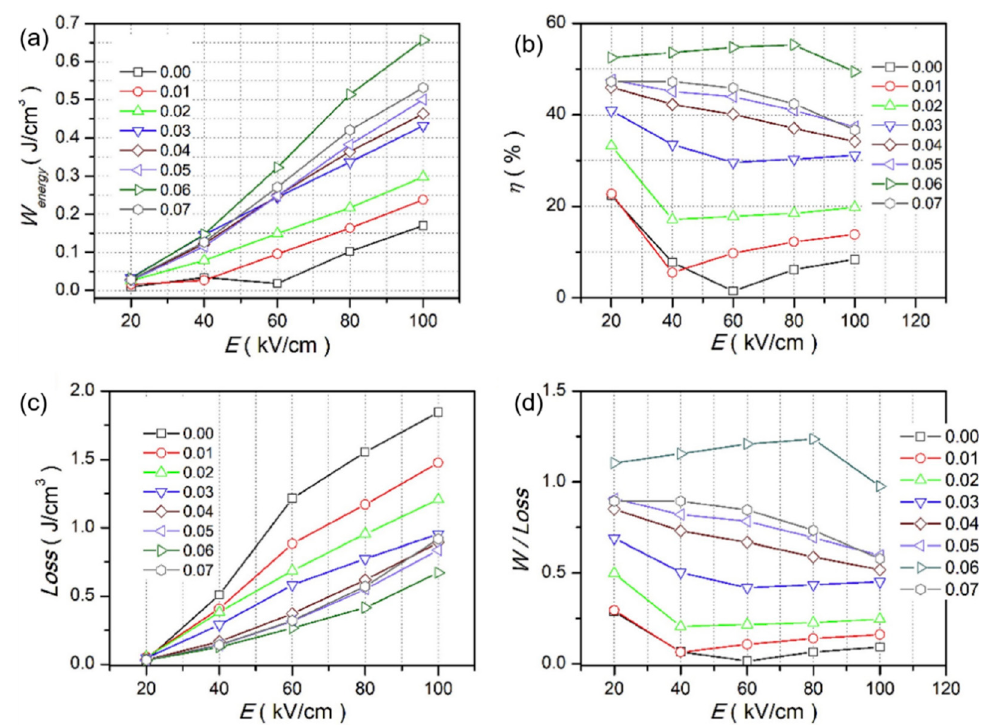
Figure 10. W energy , W loss , η and W energy /W loss of (1 − x)(BNT-12BT)-xLiNbO 3 at selected electric fields. ( a ) W energy , ( b ) η , ( c ) W loss ( d ) W energy /W loss . Reprinted with permission from [54]. Copyright 2019 Elsevier Ltd. and Techna Group S.r.l.